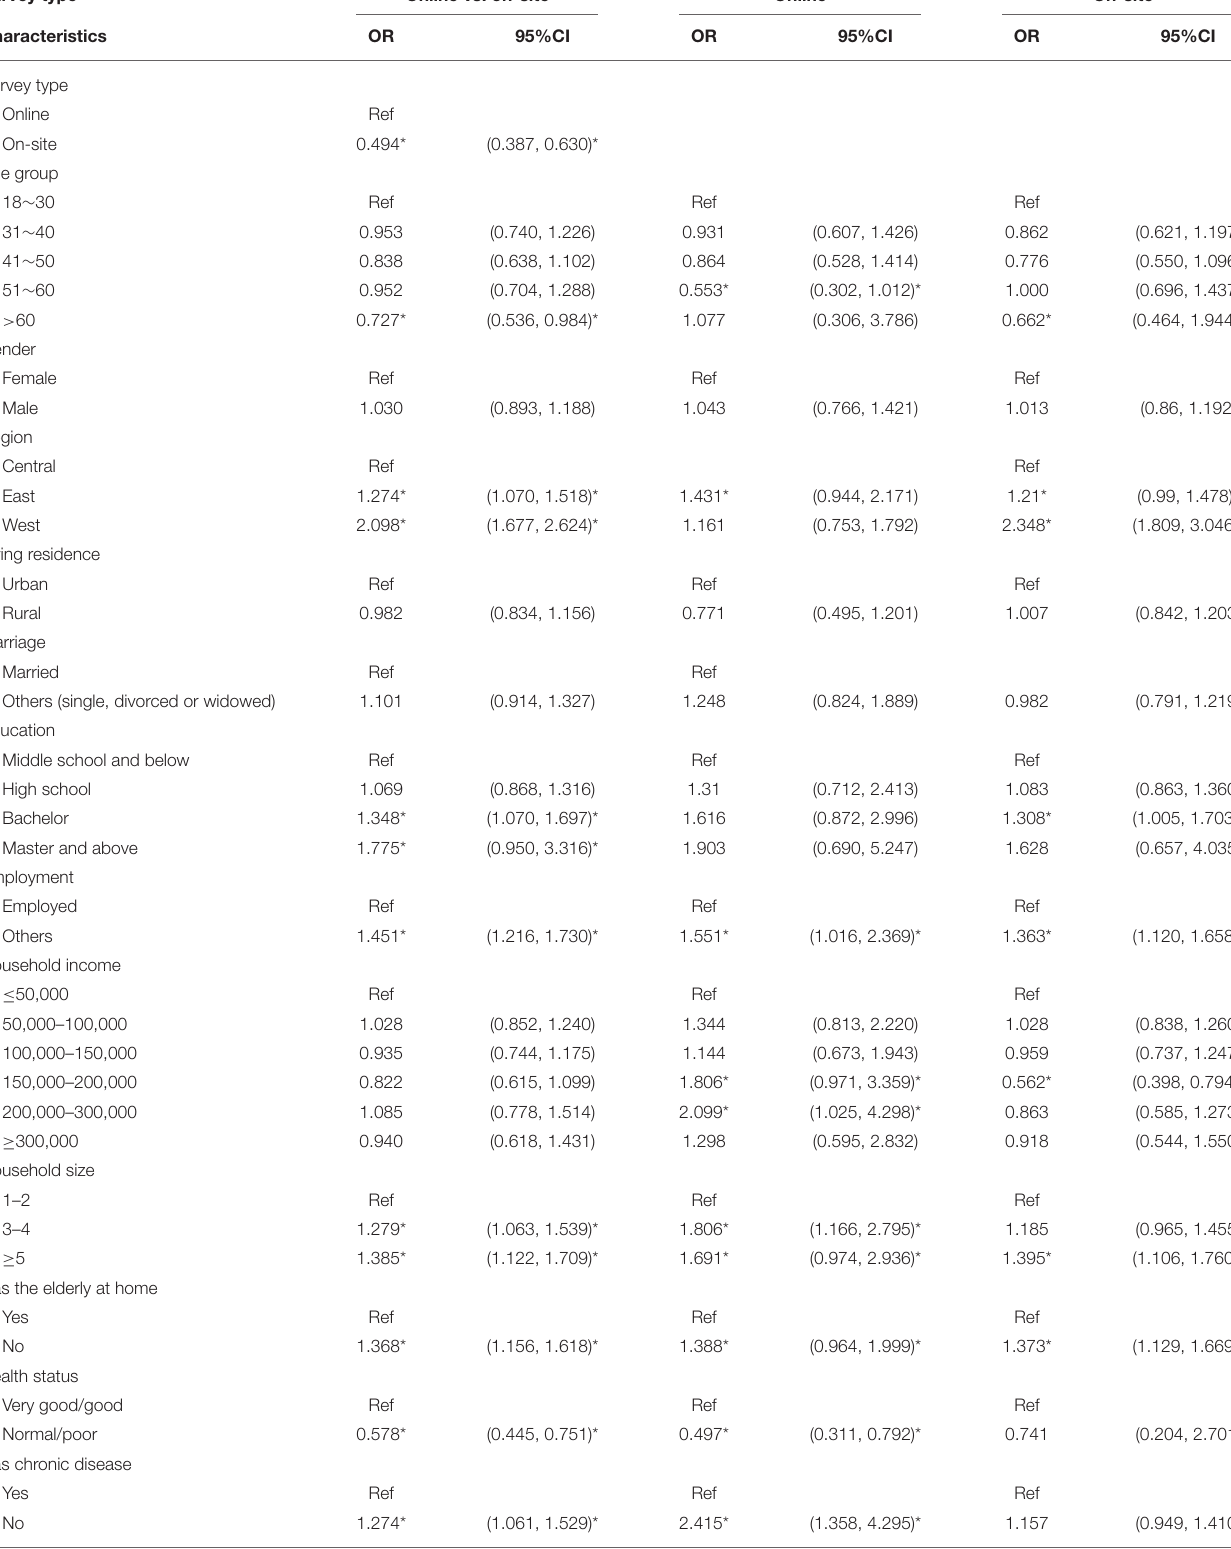
TABLE 2 | Influencing factors of vaccine acceptance in the pooled, online, and on-site samples. Survey